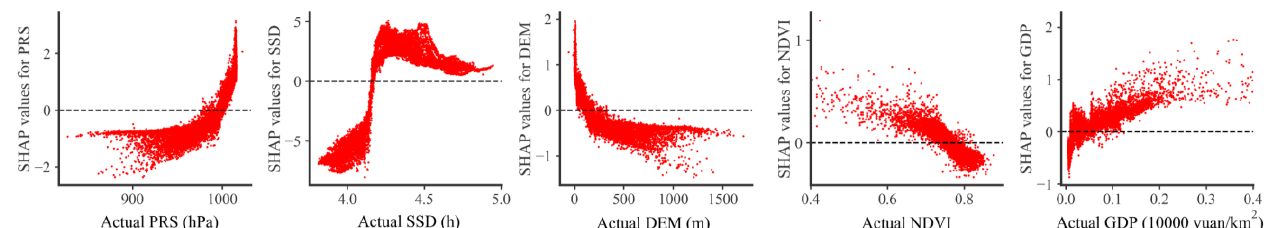
Figure 7. Dependence plot of SHAP values of key influencing factors in 2000.